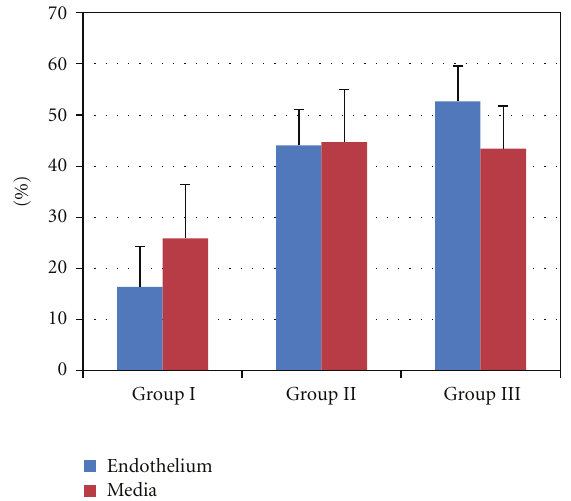
Figure 5: Changes in the percentage of apoptotic endothelial cells and smooth muscle cells. Statistically significant di ff erences in the percentage of apoptotic endothelial cells were between Group I versus Group II P < 0 . 05 and Group I versus Group III P < 0 .